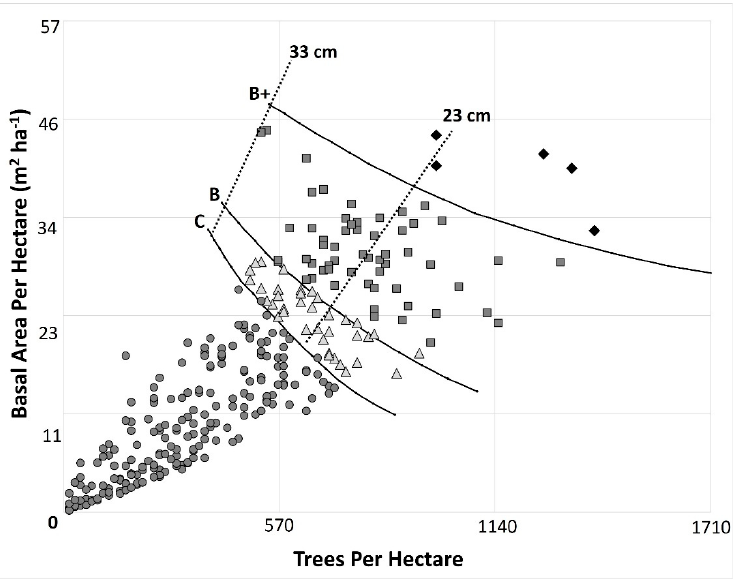
Figure 4. Example of a spruce–fir stocking guide, populated with the Forest Inventory and Analysis plots from this study. Diamonds indicate plots that have stocking at the B+ line or above. Squares are < B+ line but > B line. Triangles are plots with stocking between the B and C lines, and circles are plots with stocking below the C line. Dotted lines indicate quadratic mean diameter at breast height of 23 cm (minimum sawtimber size for spruce–fir in this region) and 33 cm.